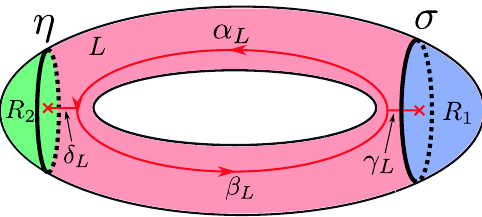
Figure 6 . States on the torus with two contractible interfaces, separating the L topological phase from two \islands" in phases R 1 and R 2